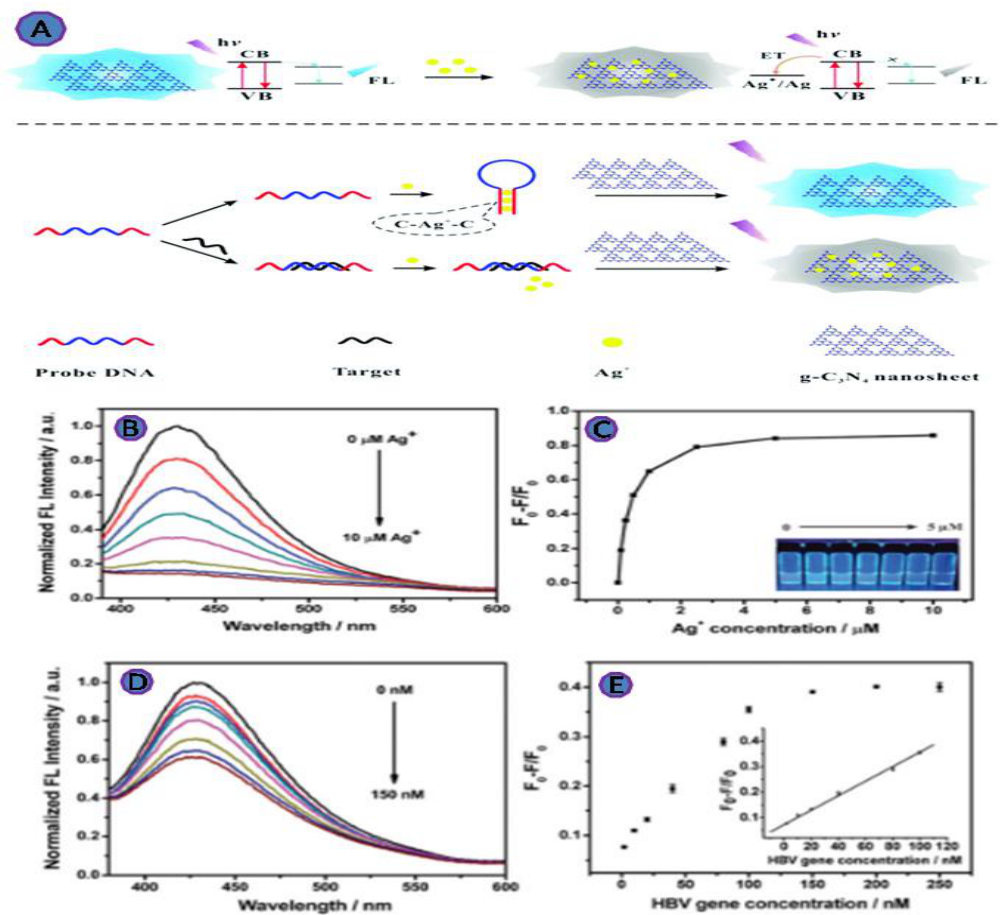
Figure 10. ( A ) A diagram of the method for detecting pathogenic DNA based on metal ion binding-induced fluorescence quenching of graphitic carbon nitride nanosheets; ( B ) fluorescence spectra of g-C3N4 nanosheets (1.0 gmL −1 ) in the presence of various silver ion concentrations; ( C ) the fluorescence intensity of g-C3N4 nanosheets was measured in the presence of various numbers of silver ions; ( D ) fluorescence spectra of g-C3N4 nanosheets in the presence of different HBV gene concentrations; ( E ) the relative fluorescence intensity of g-C3N4 nanosheets in response to various HBV gene concentrations. Reprinted with permission from Ref. [60]. Copyright 2017, ROYAL SOCIETY OF CHEMISTRY.